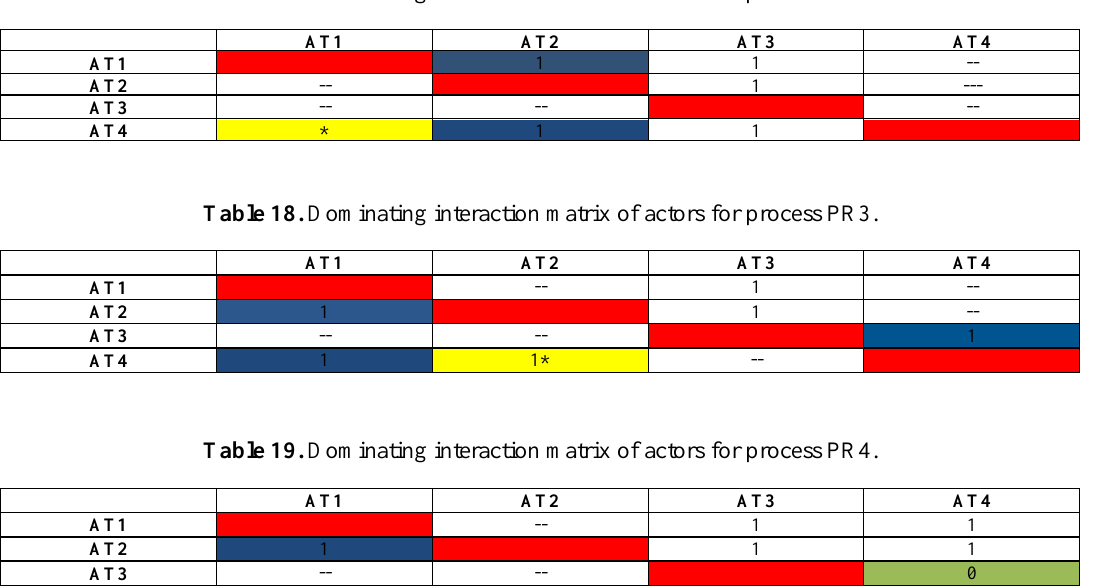
Table 17. Dominating interaction matrix of actors for process PR2.